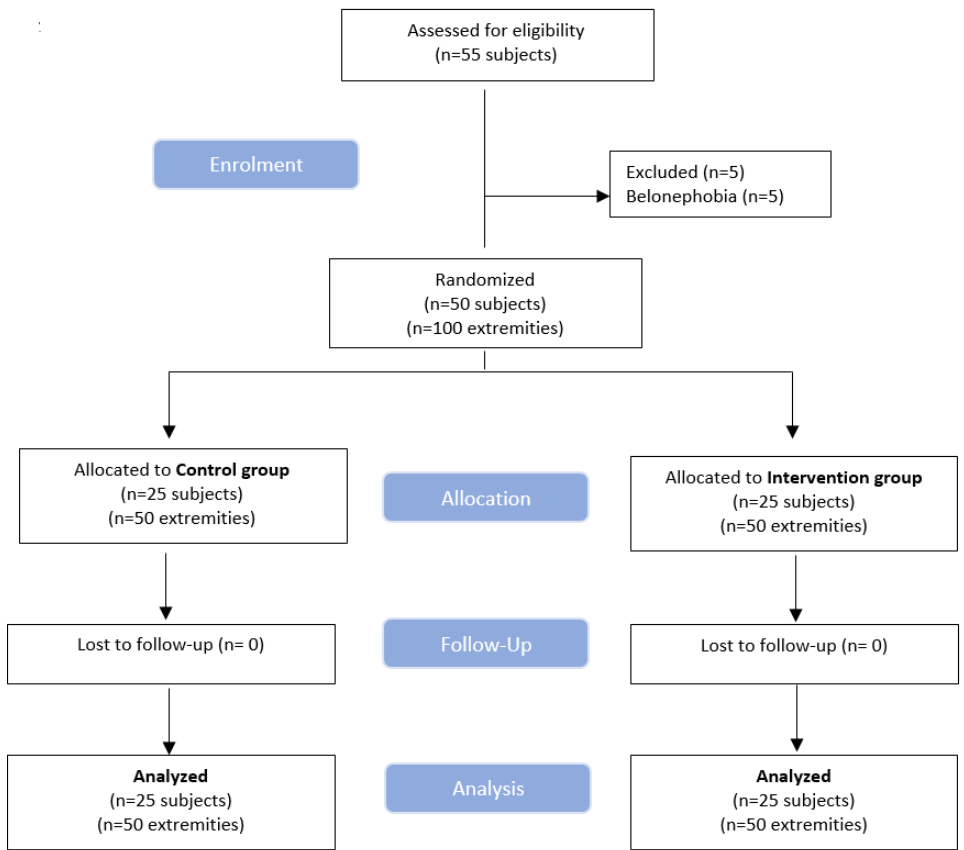
Figure 7. Flow diagram of patients throughout the course of the study, according to the Consolidated Standards of Reporting Trial (CONSORT).